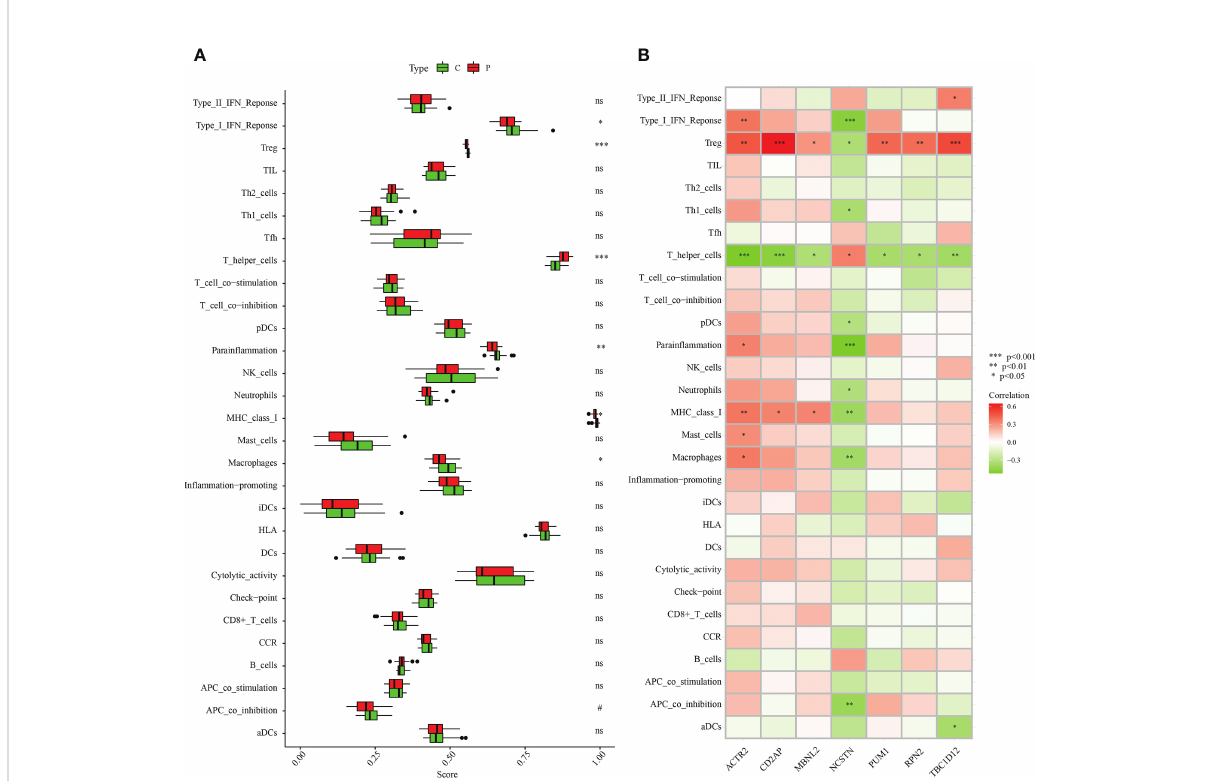
FIGURE 11 Correlation between the hub genes and immunity. (A) Comparison of the ssGSEA scores of the immune cells and immune pathways between the RM group and healthy controls. (B) Correlation between characteristic genes and immunity. *p < 0.05, **p < 0.01, ***p < 0.001. 0.05 < p < 0.2. NS, no signi fi